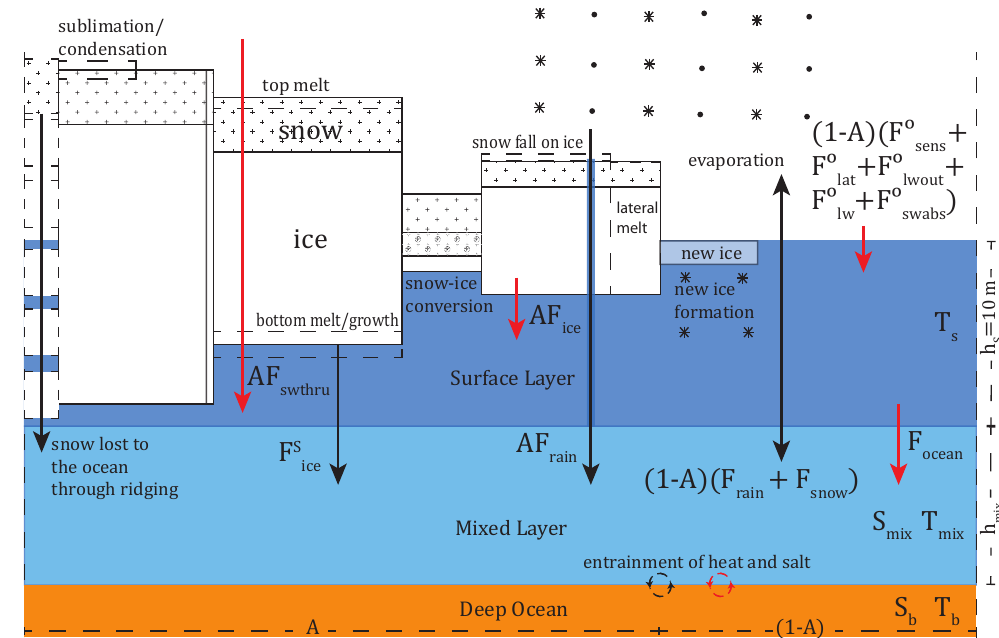
Fig. 4. Schematic of the main thermodynamic processes included in CICE. A : total ice concentration within the grid cell, F o : latent heat lat flux over the open water fraction, F o : downward long-wave radiative heat flux into the open water fraction, F o : black-body radiative lwin lwout heat flux from the open water fraction, F ice : conductive heat flux through the ice, F S : net salt flux from ice/snow growth/melt, F rain : rainfall ice over the grid cell, F ocean : ocean-surface mixed-layer heat flux, F o sens : sensible heat flux over the open water fraction, F snow : snowfall over the grid cell, F o : short-wave radiative heat flux absorbed by the open water fraction, F swthru : short-wave radiative heat flux through the swabs ice, S B : salinity directly below the mixed layer, S mix : mixed-layer salinity, T B : temperature directly below the mixed layer, T S : surface layer temperature, T mix : mixed-layer temperature. Red arrows indicate heat fluxes while black arrows indicate salt/freshwater